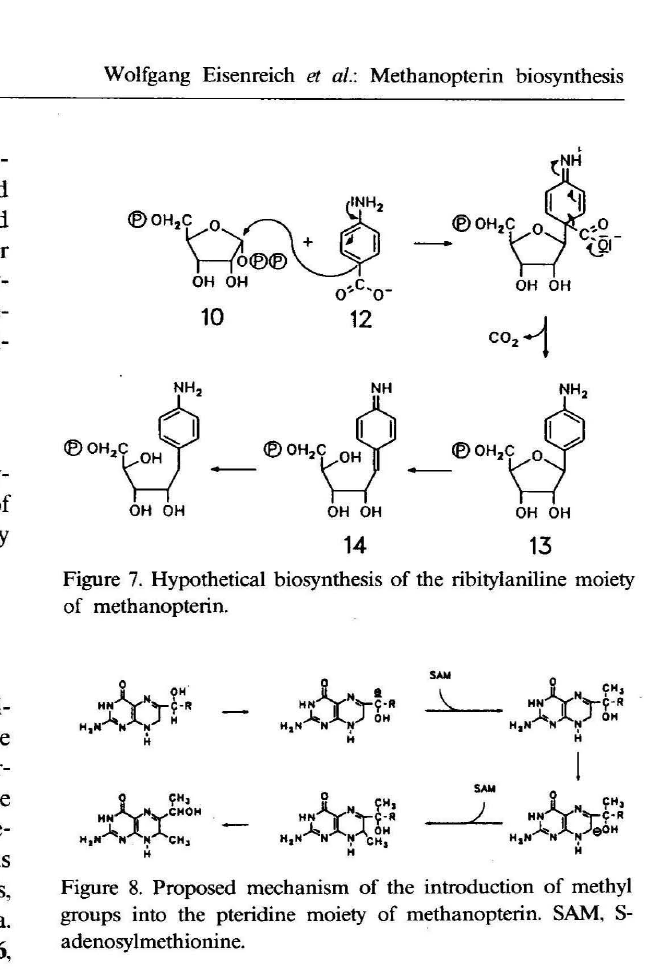
Figure 7. Hypothetical biosynthesis of the ribitylaniline moiety of methanopterin.